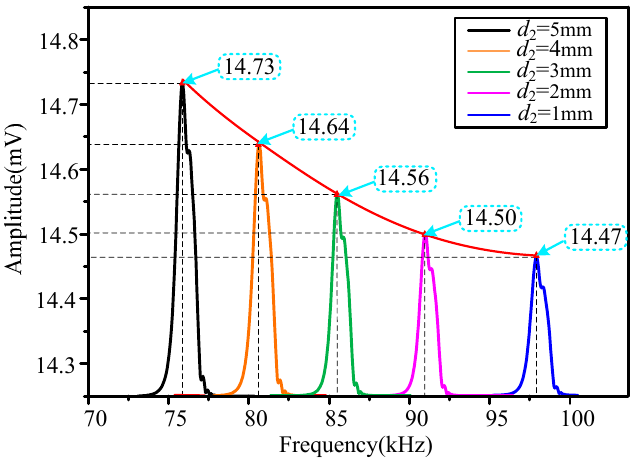
Figure 10. Plot of the voltage output versus the resonant frequency.